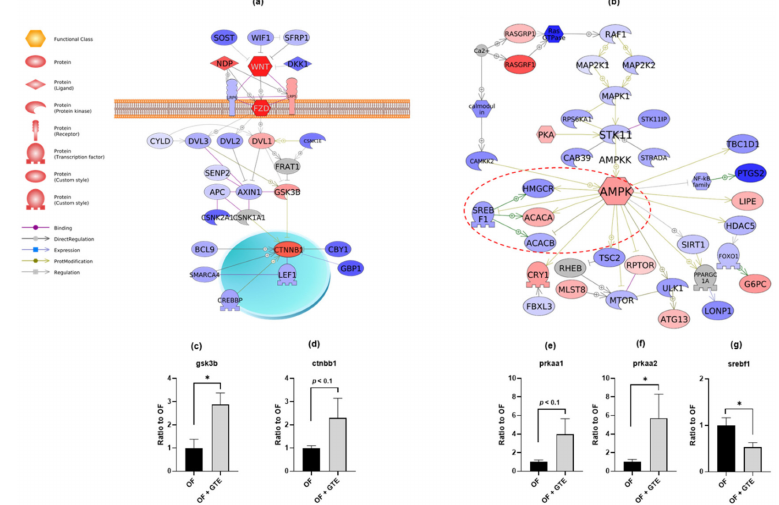
Figure 3. GTE ameliorates obesity in adult zebrafish by activating the WNT / β -catenin and AMPK signaling pathway. Biological pathways of ( a ) Wnt canonical signaling and ( b ) AMPK signaling were identified by Pathway Studio using altered genes in GTE-treated obese zebrafish compared with those of OF zebrafish. The red and blue colors denote genes with increased and decreased expression, respectively. Grey denotes the genes that were not detected in the RNA-seq assay, including FRAT regulator of WNT signaling pathway 1 (FRAT1), casein kinase 1 alpha 1 (CSNK1A1), Ras homolog, mTORC1 binding (RHEB) and PPARG coactivator 1 alpha (PPARGC1A). Gene expression changes of gsk3b ( c ), ctnbb1 ( d ), prkaa1 ( e ), prkaa2 ( f ), and srebf1 ( g ) were validated by qPCR analysis. The red dotted line indicates the sterol regulatory element-binding transcription factor 1 (SREBF1) branch of the AMPK pathway. * p < 0.05 vs. OF group, n = 4, error bars indicate